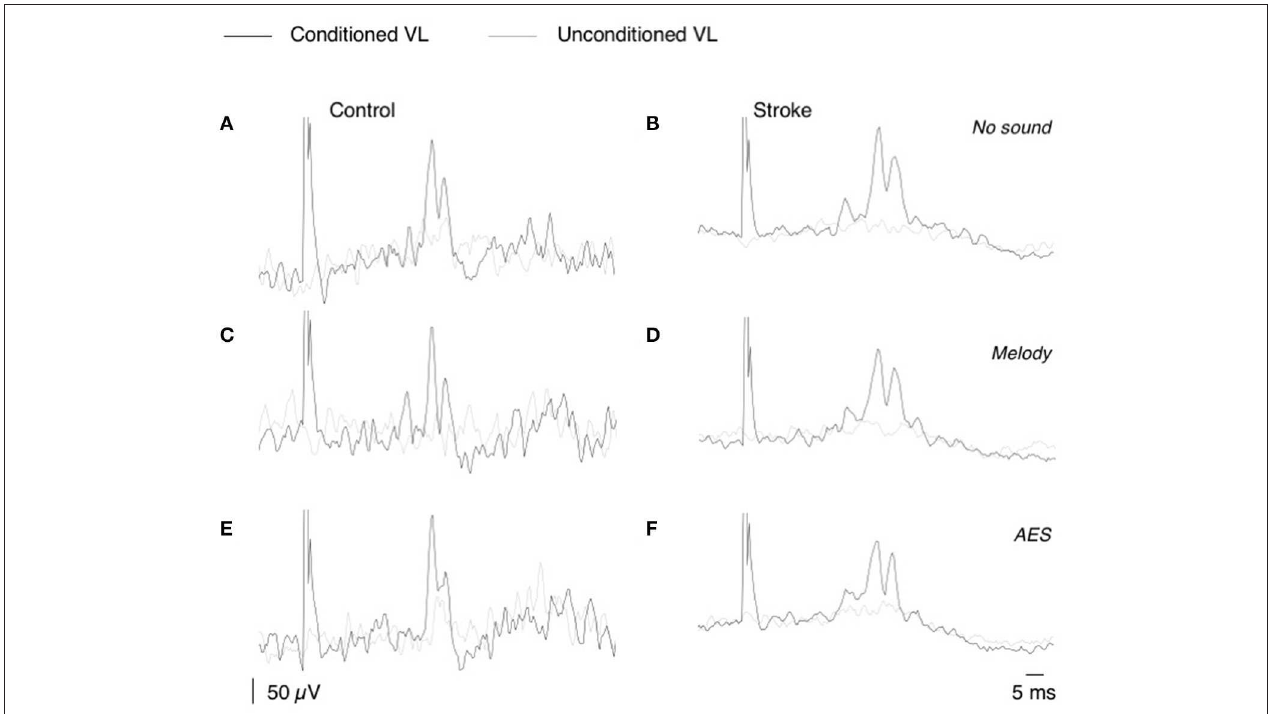
FIGURE 2 | CPQ reflex produced by CP nerve stimuli on VL EMG. (A,F) Mean unconditioned (gray line) and mean conditioned (black line) rectified VL EMG in one control subject (A,C,E) , and one patient (B,D,F) ; same subjects as in Figure 1 . The CP nerve stimulation ( N = 50, 2–2.5 × MT) was triggered by the heel contact and was delivered with 0-ms delay in the control subject and 40-ms delay in the patient. Unconditioned and conditioned recordings were randomly alternated during the EMG acquisition performed without sound (A,B) , with melody (C,D) , or AES (E,F)